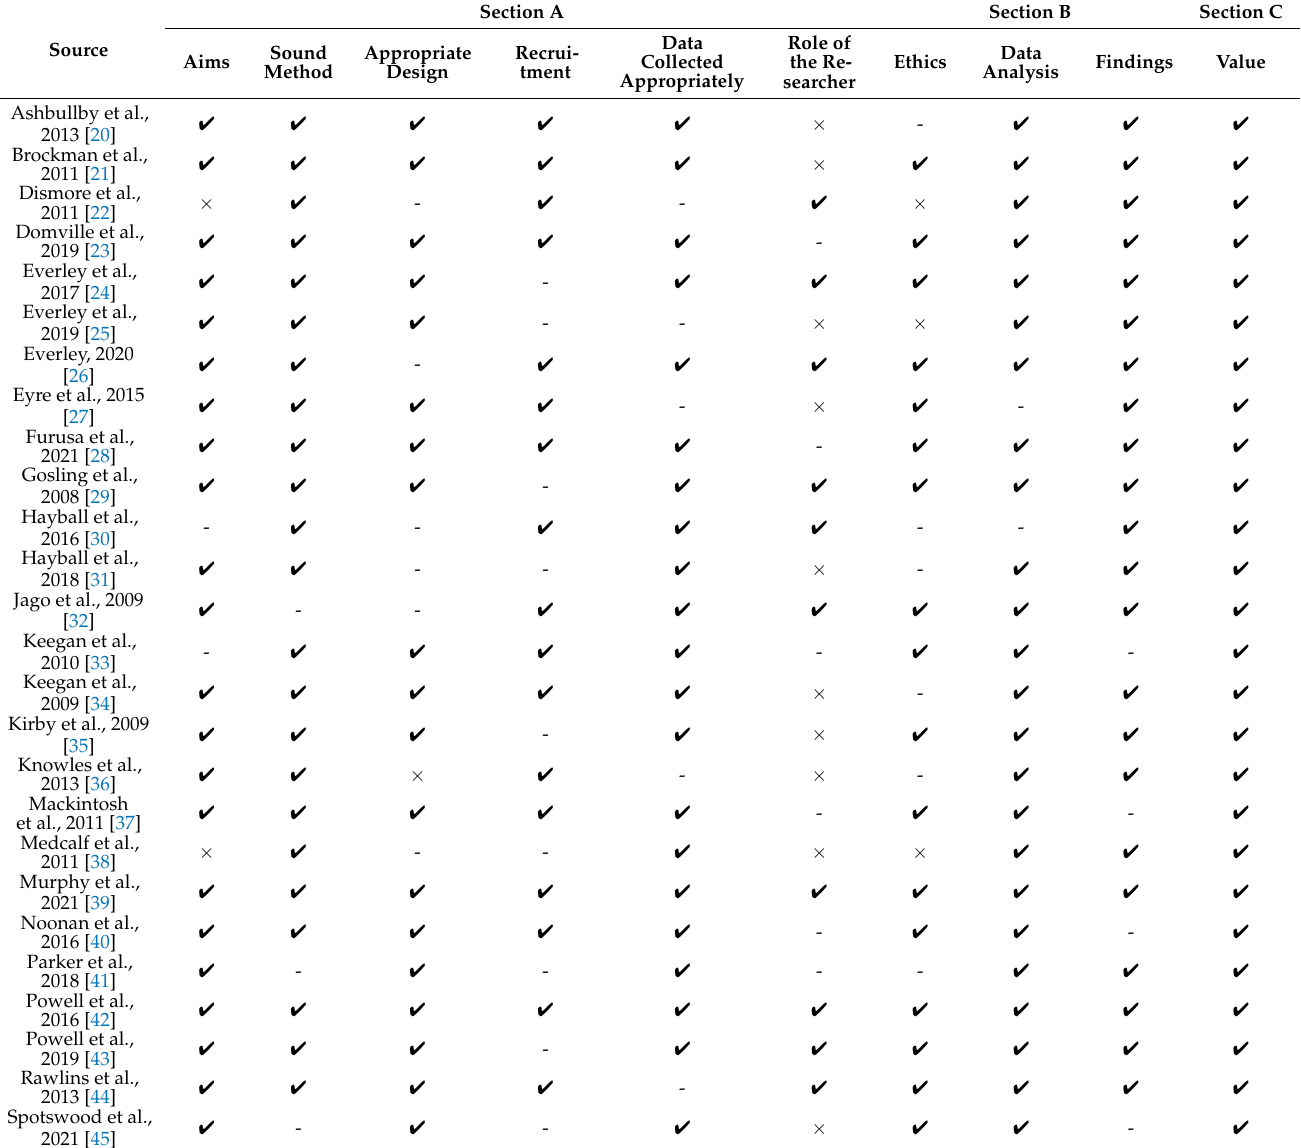
Table 2. Quality appraisal using the CASP